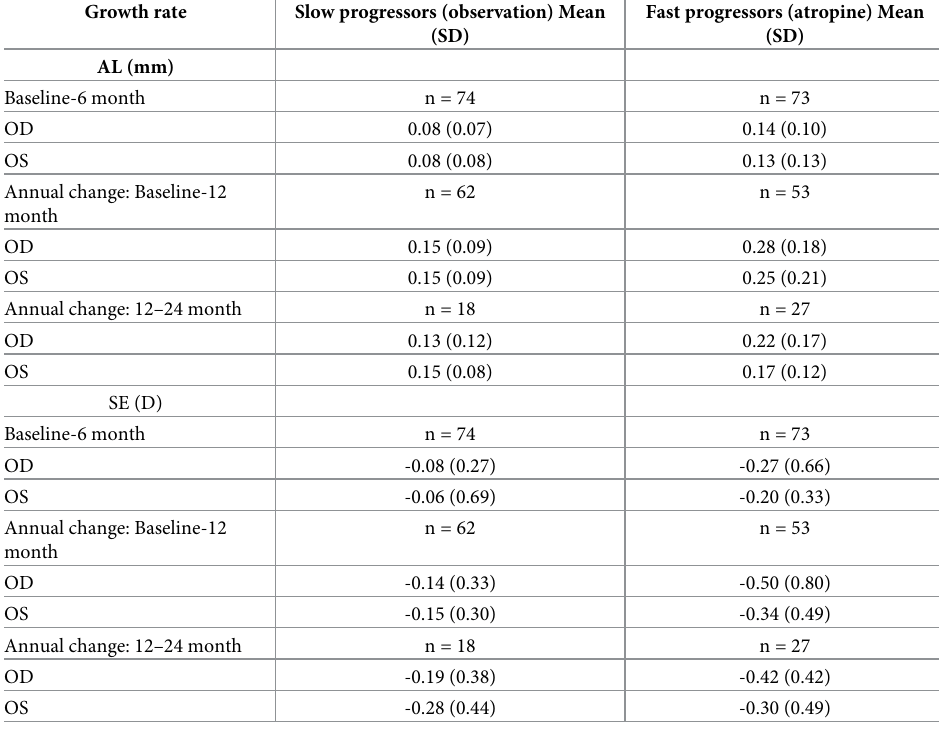
Table 3. Progression rate of observation and treatment group. Growth rate Slow progressors (observation) Mean